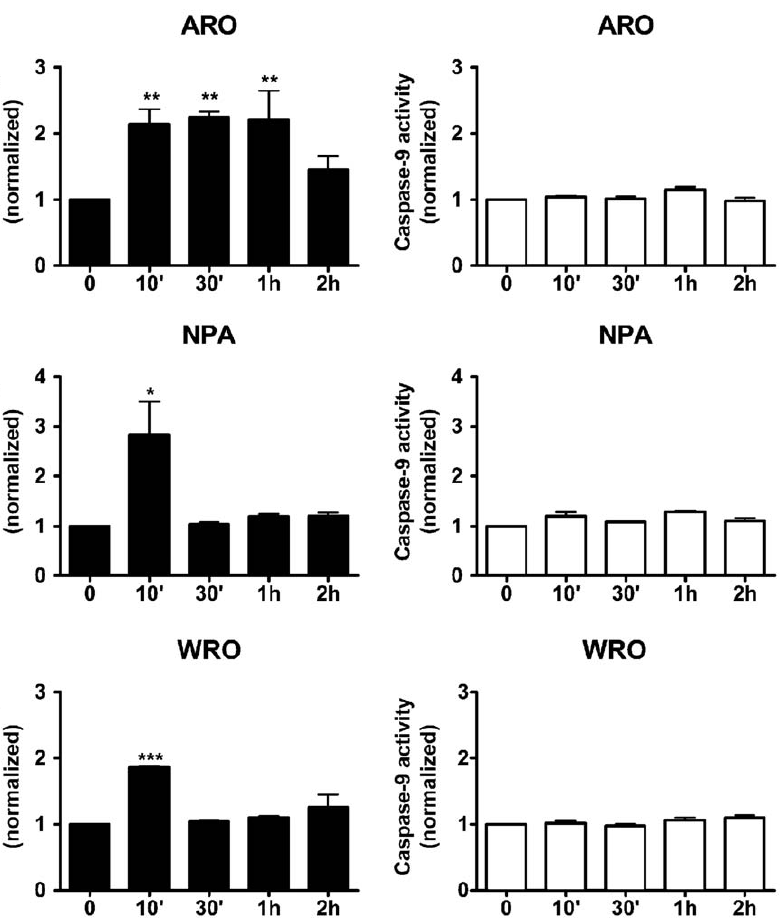
Figure 3. Effect of 8-Cl-cAMP on caspase 8 and 9. ARO, NPA and WRO cells were exposed to 8-Cl-cAMP (200 m M) for different periods of time and the activities of caspase 8 and 9 were measured utilizing specific luminescent assays. Data are from three to six independent experiments. * P , 0.05 vs. basal. ** P , 0.01 vs. basal. *** P , 0.001 vs. basal. All data are expressed as the variation versus baseline.